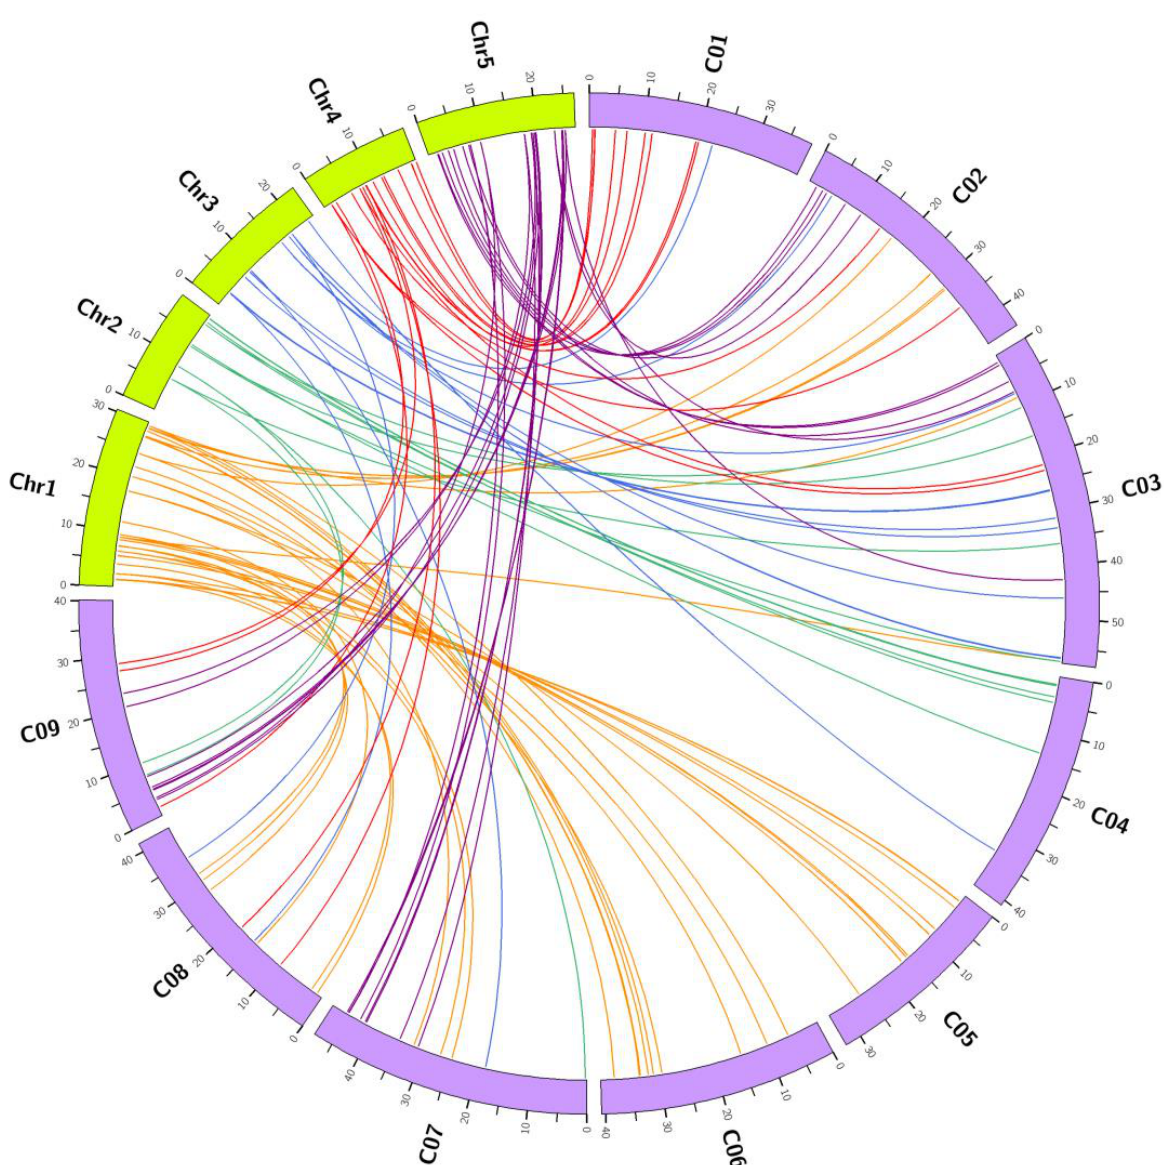
Figure 2. Circos diagram of glucosinolate biosynthetic genes in Brassica oleracea and Arabidopsis thaliana . C01 to C09 denote Brassica oleracea chromosomes, and Chr1 to Chr5 denote Arabidopsis thaliana chromosomes.